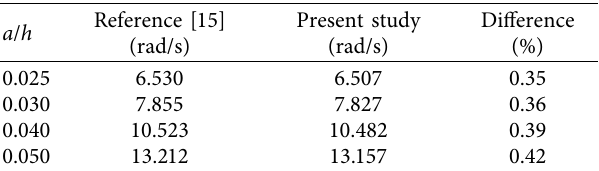
Table 1: The first natural frequency of a circular cylinder with E � 29.4GPa, ρ s � 2450kg/m 3 , and h �